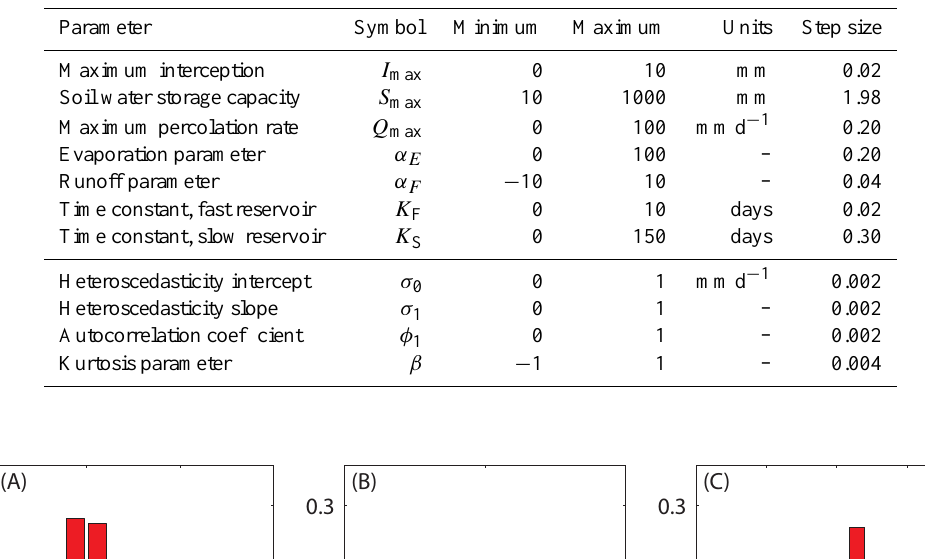
Table 1. Prior Uncertainty Ranges of Hydrologic and Error Model Parameters.